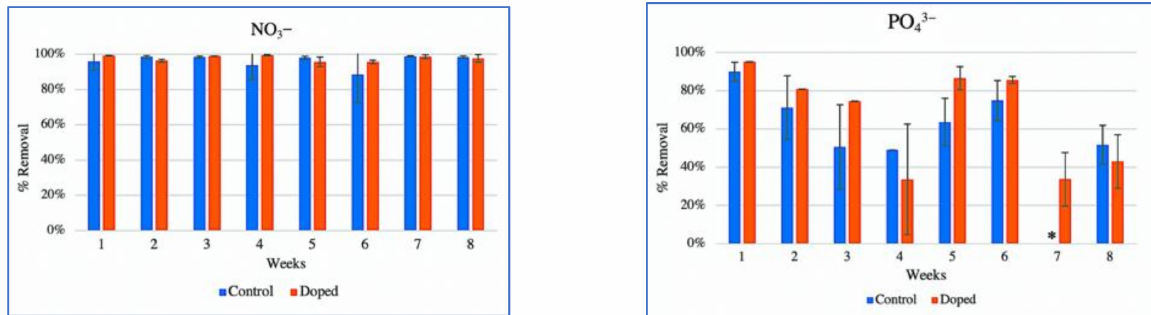
Figure 1. Removal percentage (%, mean and standard deviation, n = 3) of ammonia (NH 4+ ), nitrite (NO 2 − ), nitrate (NO 3 − ) and phosphate (PO 43 − ) ions in CWs irrigated for eight weeks with Ribeira de Joane water not doped (control) or doped with NP and OP. * In week seven of control treatment there was no PO 43 − ions removal.